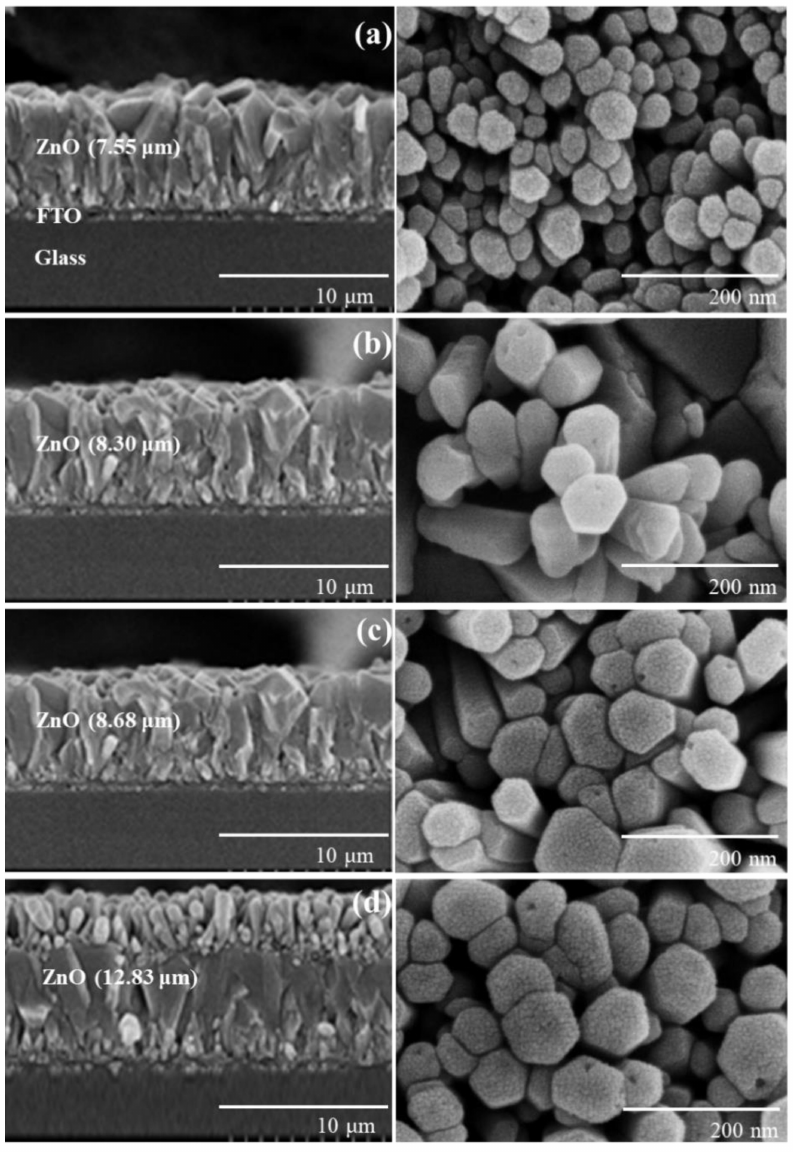
Figure 1. Cross-sectional ( left ) and top view ( right ) SEM images of ZnO nanoroads formed on FTO glasses for ( a ) 4, ( b ) 6, ( c ) 8, and ( d ) 10 h growth